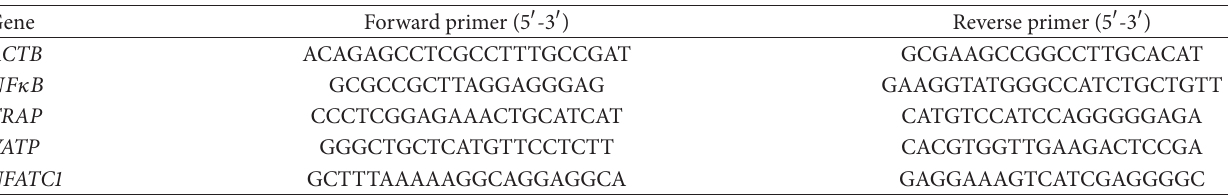
Table 1: Primers used for RT-PCR analysis.